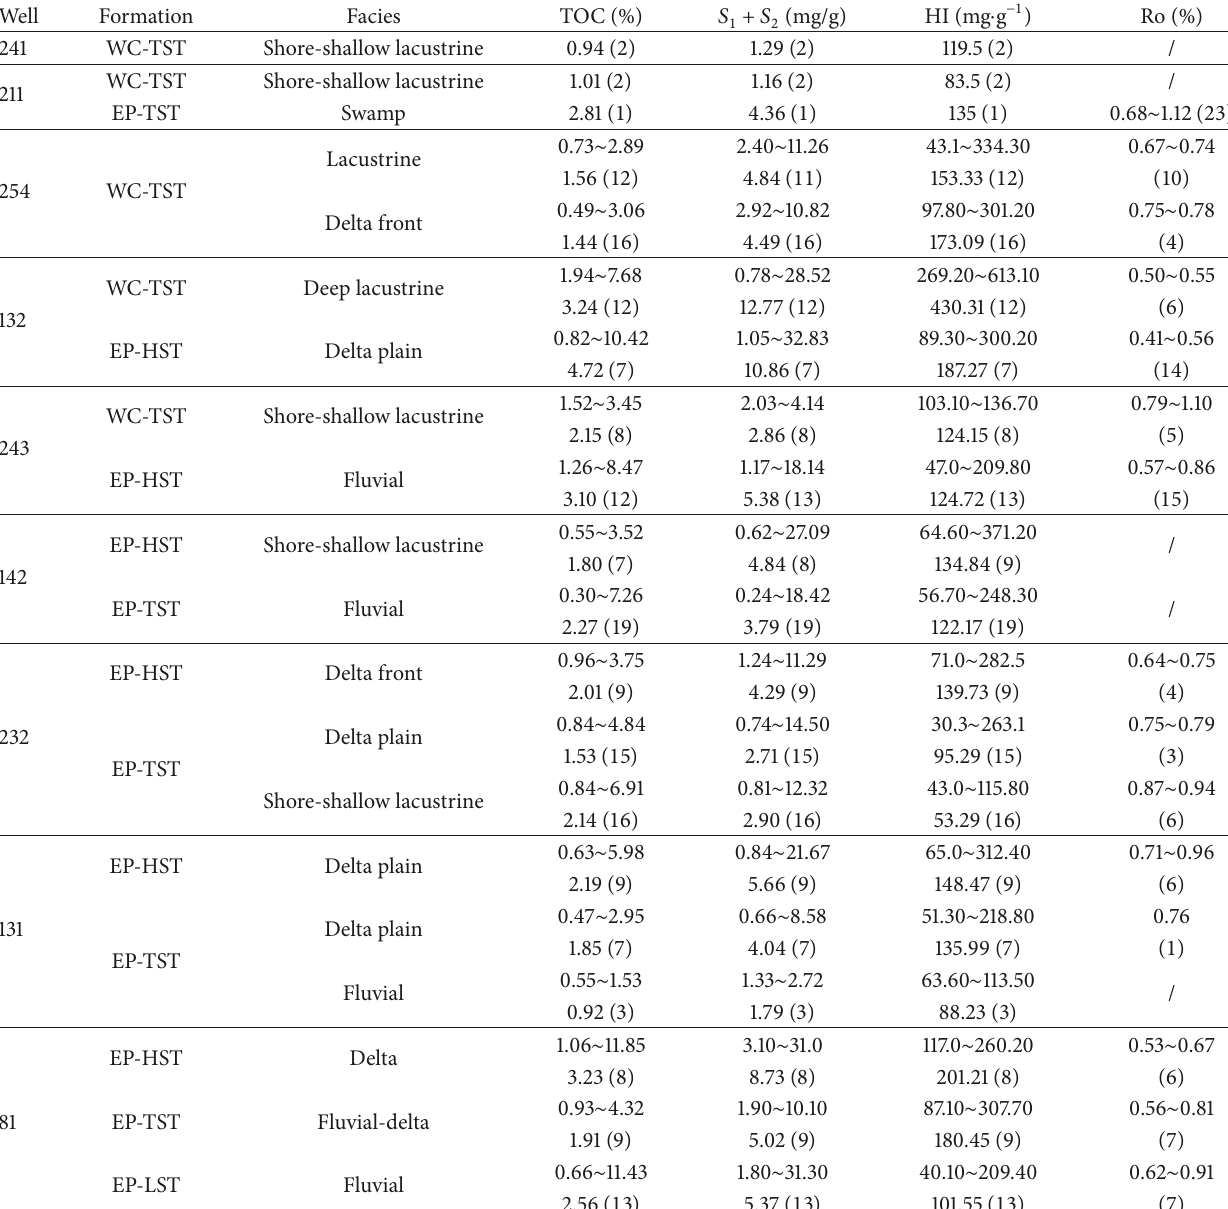
Table 2: The characteristics of source rocks with different facies of the Eocene Wenchang and Enping Formation in the Huizhou Sag (HZS).